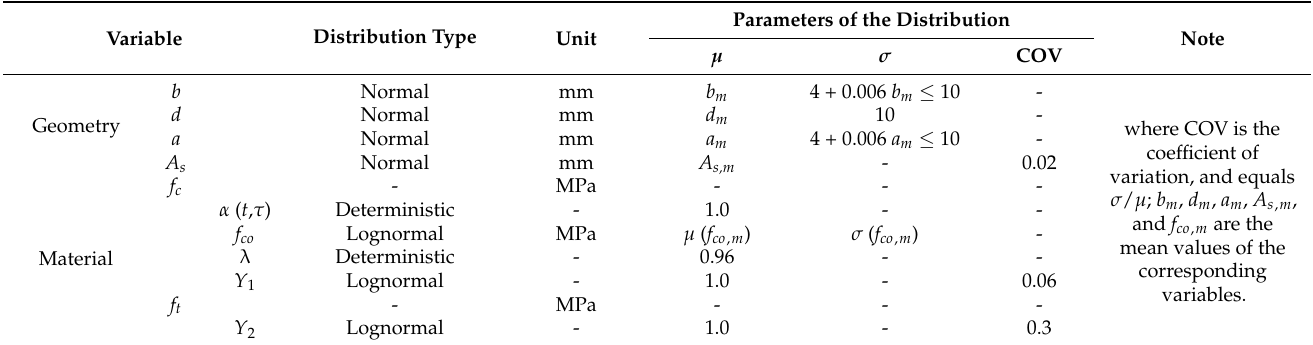
Table 4. Probabilistic properties of the variables considered by the models.